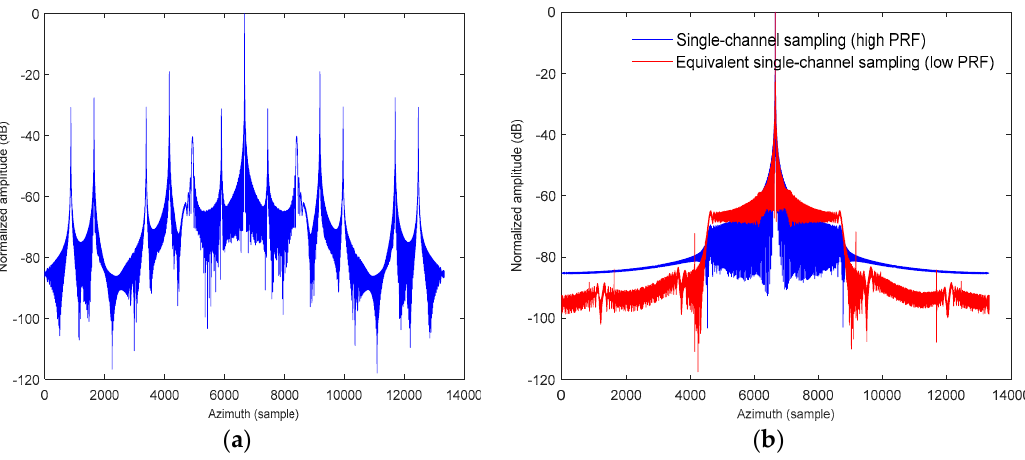
Figure 9. The azimuth response of DPCAM SAR for hypersonic platform: ( a ) without spectrum reconstruction; ( b ) with spectrum reconstruction.